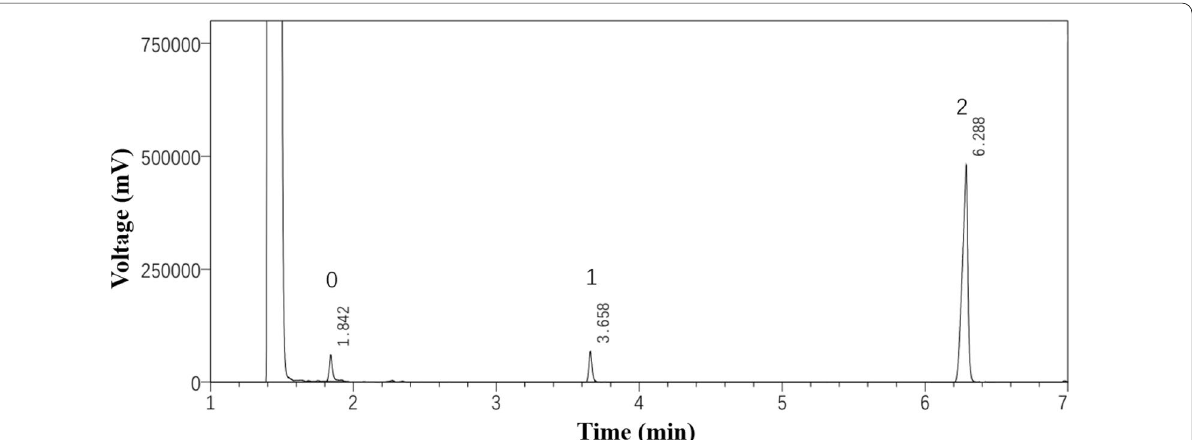
Fig. 2 The GC chromatograms of the products during enzymatic esterification. 0—stands for LA (1.842 min); 1—stands for monosubstituted BDO esters (3.658 min); 2—stands for disubstituted BDO esters (6.288 min)